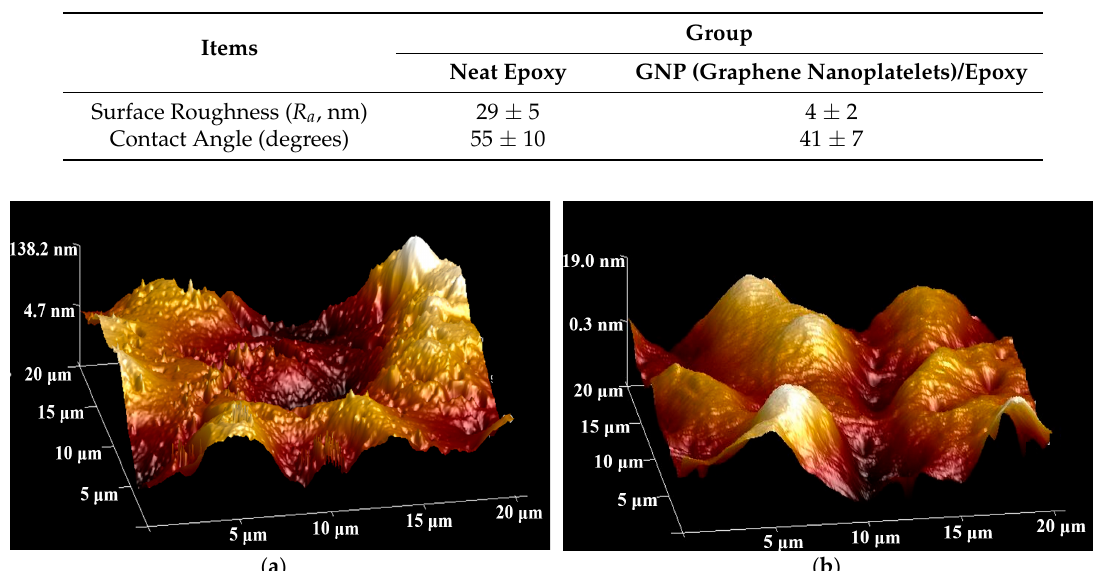
Figure 12. Water contact angle for ( a ) the neat epoxy, ( b ) group 1.0%G-Epoxy. Table 1. Surface roughness and contact angle of the composite coatings.